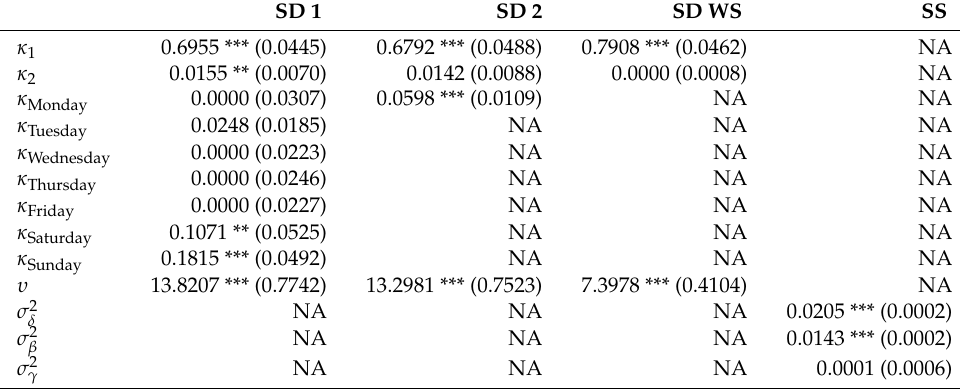
Table A3. Parameter estimates for